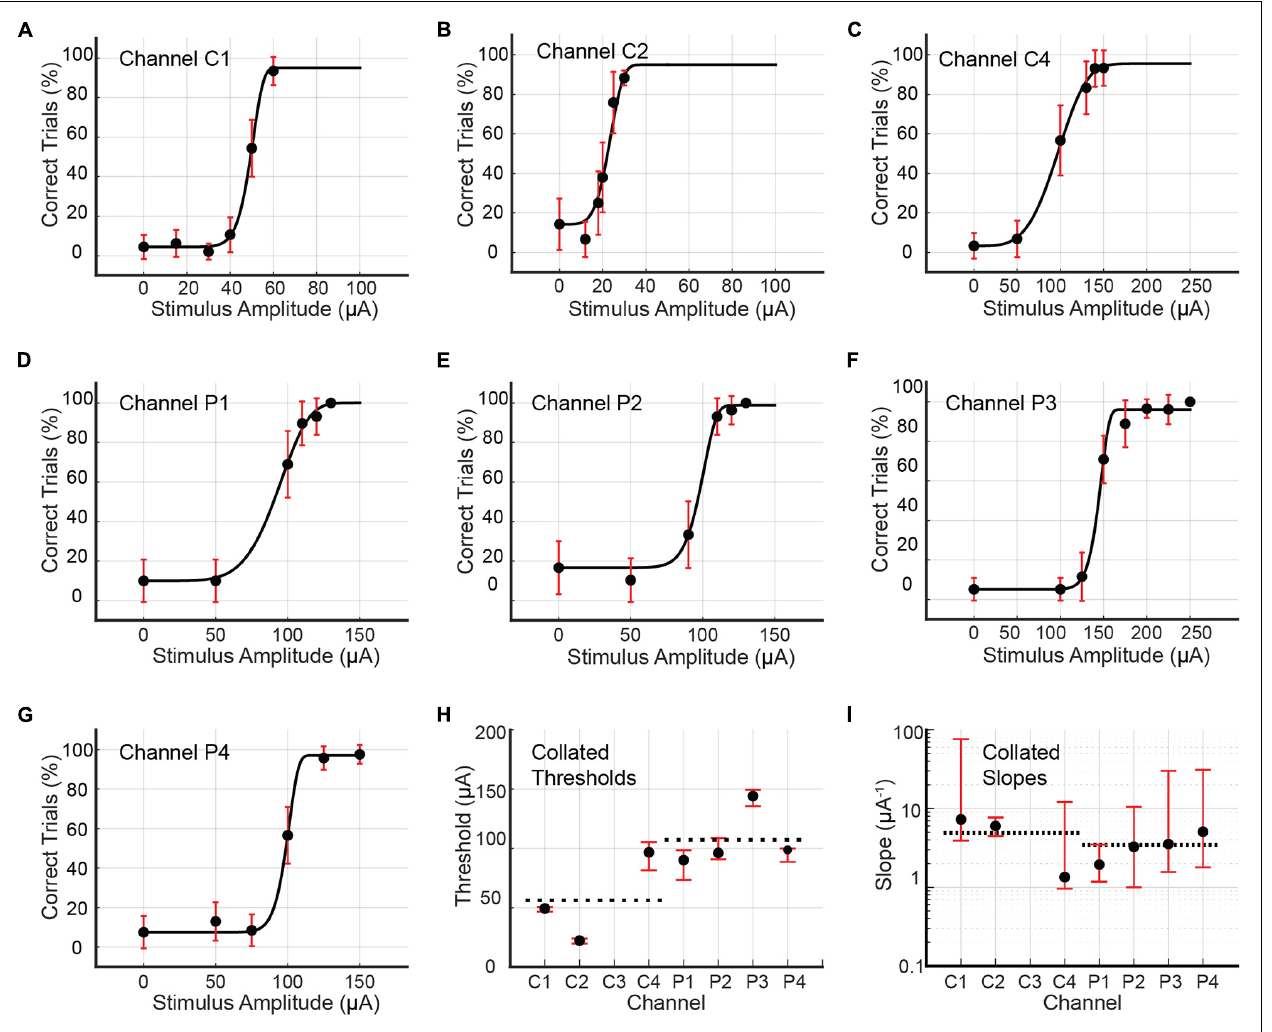
FIGURE 7 | (A–G) Psychometric curves for Rat C generated by single-channel stimulation through individual channels C1, C2, C4, P1, P2, P3, and P4. Single-channel stimulation by channel C3 elicited no leg twitch or behavioral response up to 200 µ A, precluding the generation of a psychometric curve for this channel. Error bars represent 95% confidence intervals for binomial distribution based on detection probability. See Table 3 for fitted parameters, 50% detection thresholds, slopes, and goodness of fit metrics. (H,I) Collated 50% detection thresholds ( x T ) and slopes ( ψ (cid:48) ( x T ) ) extracted from the preceding seven psychometric curves. Horizontal dotted lines depict mean values for core and peripheral channels. Error bars represent 95% BC a confidence intervals.